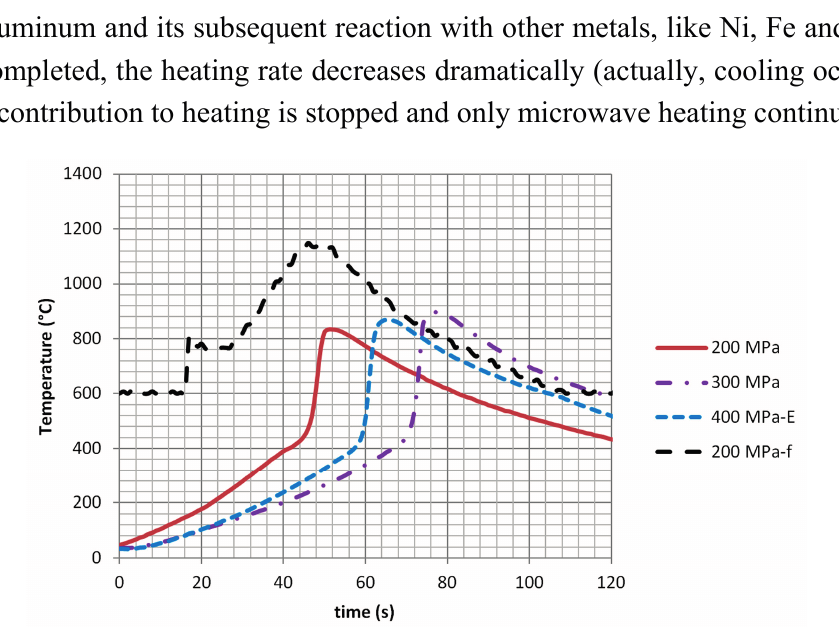
Figure 2. Heating curves of the Fe + Co + Ni + Cu + Al powder compacts measured by optical pyrometer: microwave heating at 240 W forward power, 5800 MHz, in predominant electric field regions of the microwave applicator. Different forming pressures applied; suffix “-f” indicates temperature monitored by sapphire fiber; suffix “-E”, electric